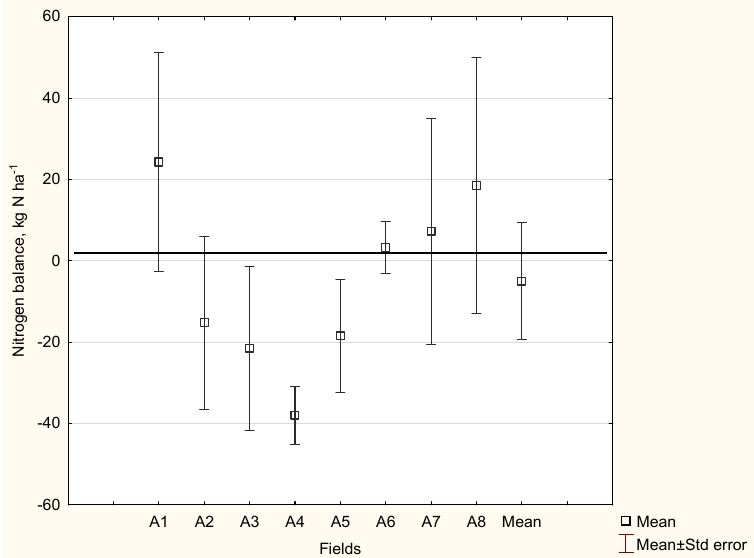
Figure 6. The simplified nitrogen (N) balance for a cereal farm in Poland. Legend: N input included: N f —fertilizer nitrogen and N CRs —nitrogen in crop residues; N output included N Y —nitrogen accumulated in the yield.